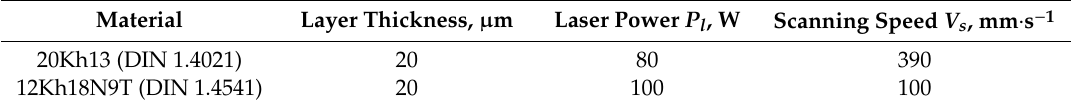
Table 2. Laser powder bed fusion factors for growing